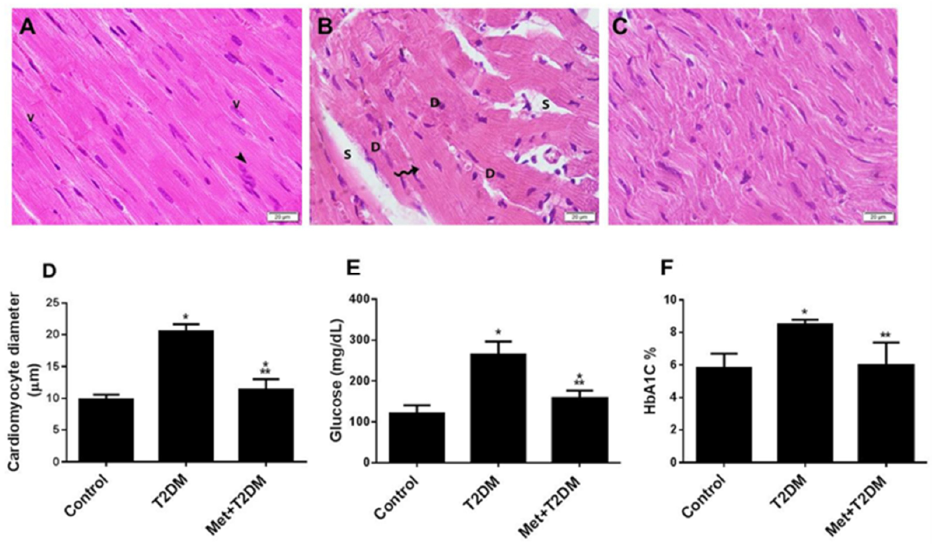
Figure 1. Metformin (Met) protects the cardiac architecture against injuries secondary to T2DM. H&E-stained images (400 × ) of left ventricles obtained 10 weeks post diabetic induction from the control untreated ( A ), T2DM ( B ), and Met + T2DM ( C ) groups are illustrated (Scale = 20 µ m). Note that the arrowhead in ( A ) points to the intercalated disc, and the wavy arrow in ( B ) points to dilated cardiac myocytes. V: vesicular nuclei; S: spaces between cardiac cells; D: darkly stained nuclei; H&E: hematoxylin and eosin; T2DM: type 2 diabetes mellitus. Histograms in ( D ) represent a quantitative analysis of cardiomyocytes injury assessed on the basis of the cardiomyocyte diameter in µ m in the groups described above. ( E , F ) Blood levels of glucose ( E ) and glycated hemoglobin ( F ) were measured at the end of the experiment, at week 12. The presented p values are all significant. * p < 0.05 versus control, ** p < 0.01 versus T2DM.